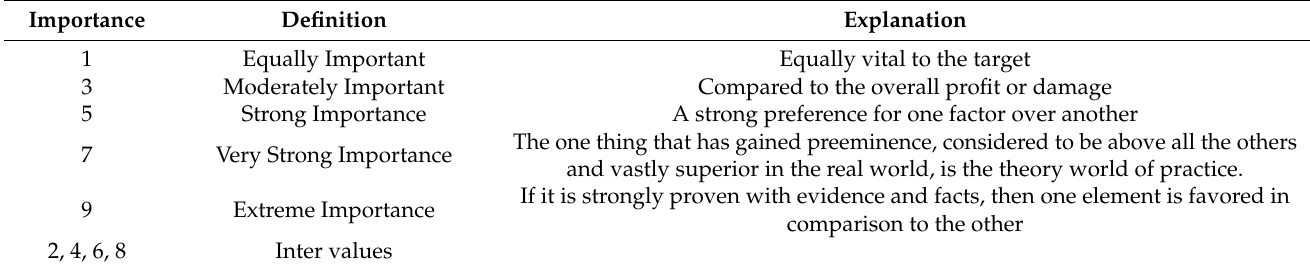
Table 1. The ratio scale and definition of AHP [28].